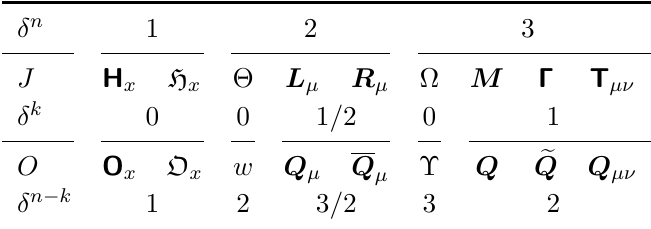
Table 11. Order in δ at which we evaluate the LERs. The first row shows the order in δ at which we evaluate the χ PT generating functional, the second row shows the δ scaling of the external current, and the final row shows the resulting order in δ for the LER. While a momentum suppression ∝ ∂ 2 counts towards the scaling of the external currents, a large n suppression does not, because it c is associated with the structure of the QCD diagrams that couple to the external current rather than with the current itself. The order in δ at which we evaluate the χ PT generating functional is chosen such that we include the leading nonvanishing contribution for each operator. For Q , we also include NLO contributions, since these enter at LO into the approximate factorised expressions for the four-quark operators. Note also that the product of operators does not scale as the sum of their individual suppressions. For instance, Q µ ∝ n 2 ∂ 2 ∝ δ , rather than δ 3/2 × δ 3/2 = δ 3 , as µ Q c one might naively